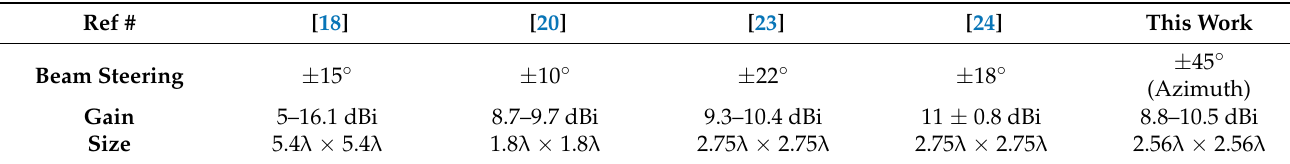
Table 4. Comparison with the